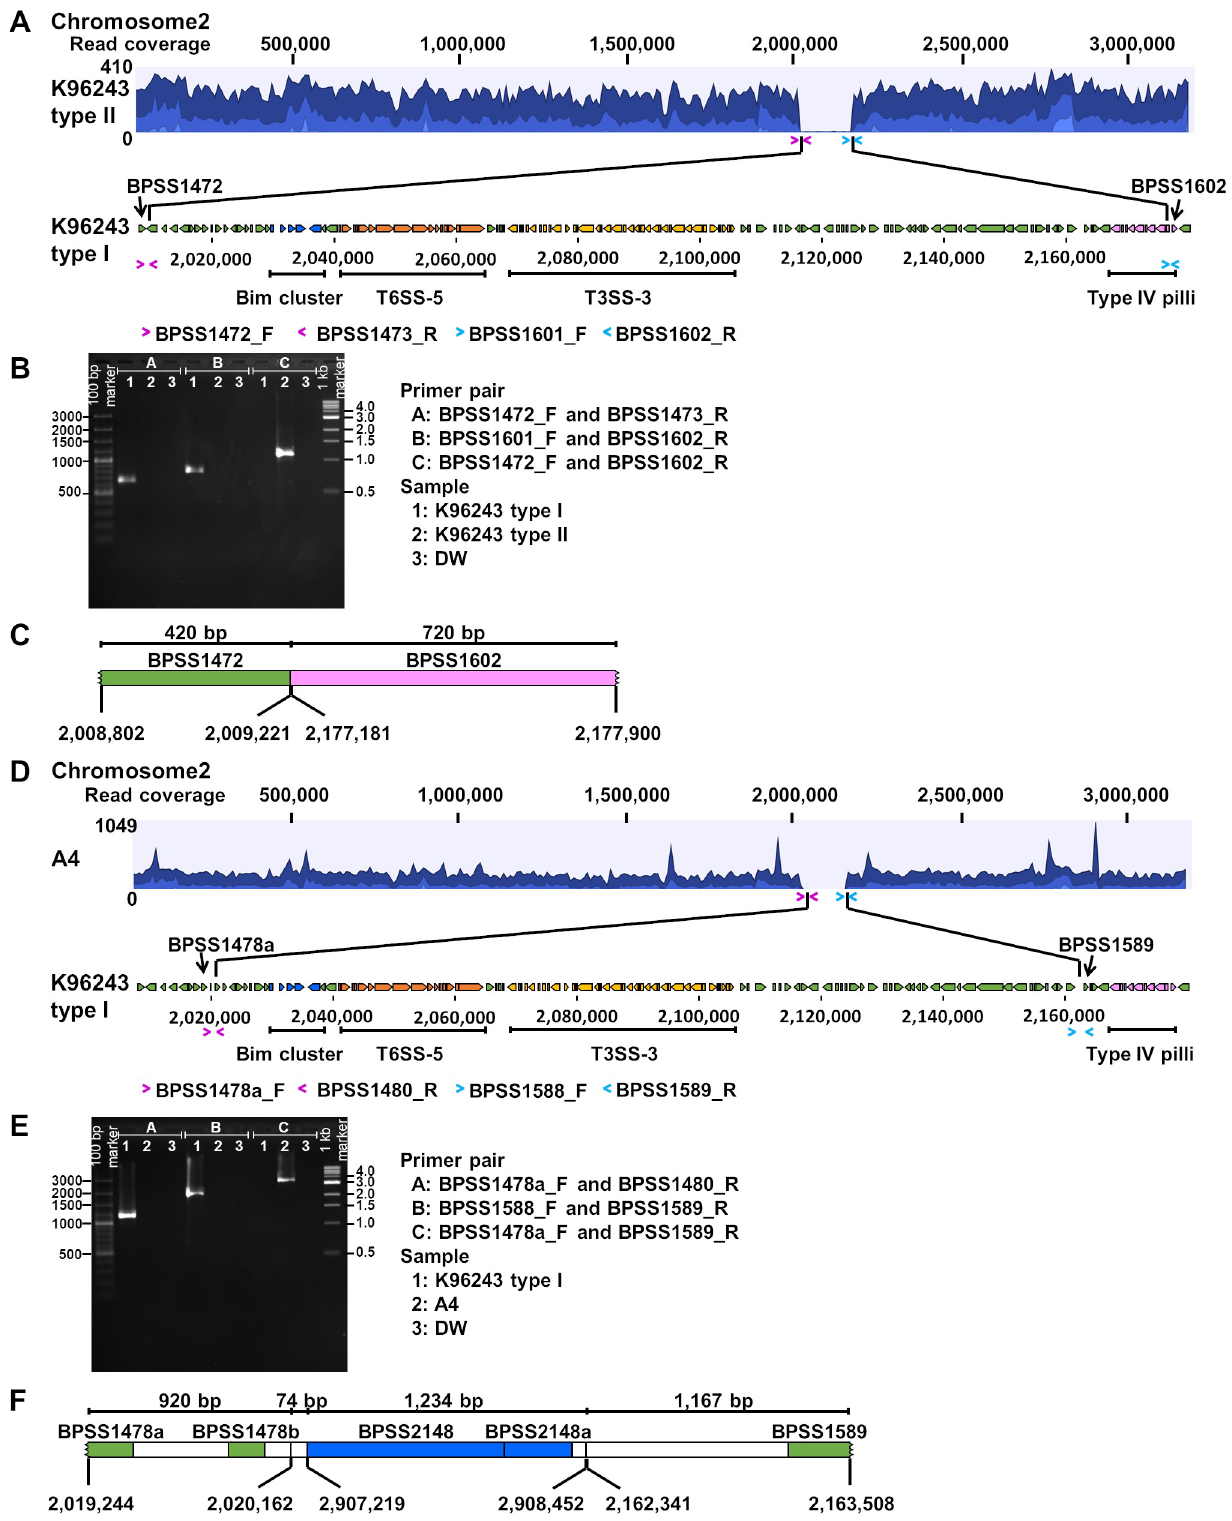
Fig 4. Large genomic loss in the chromosome 2 of B . pseudomallei K96243 type II and A4. Analyses of K96243 type II and A4 are shown in A-C and D-F respectively. Whole genome sequencing was performed on the Ion Torrent platform. Short reads from K96243 type II and A4 genomes were